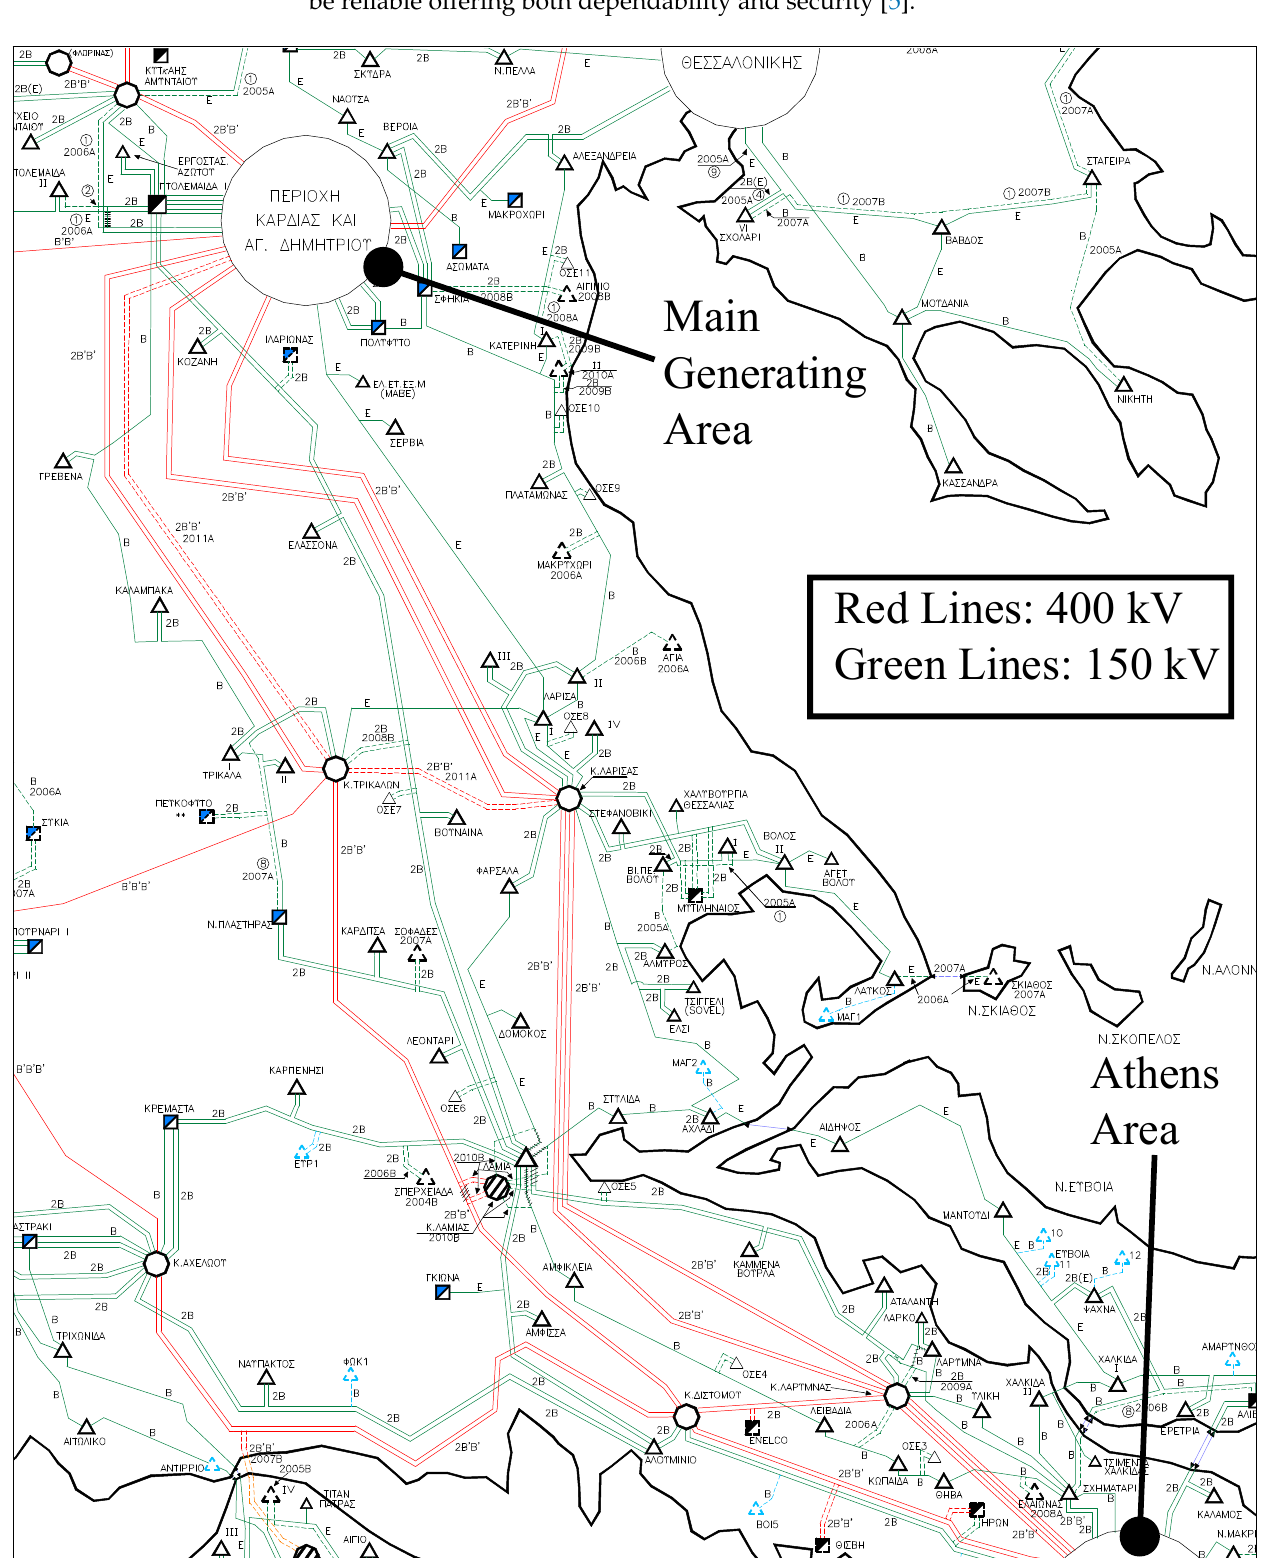
Figure 2. North–south transfer corridor at 400kV, shown with red color, Hellenic Interconnected System